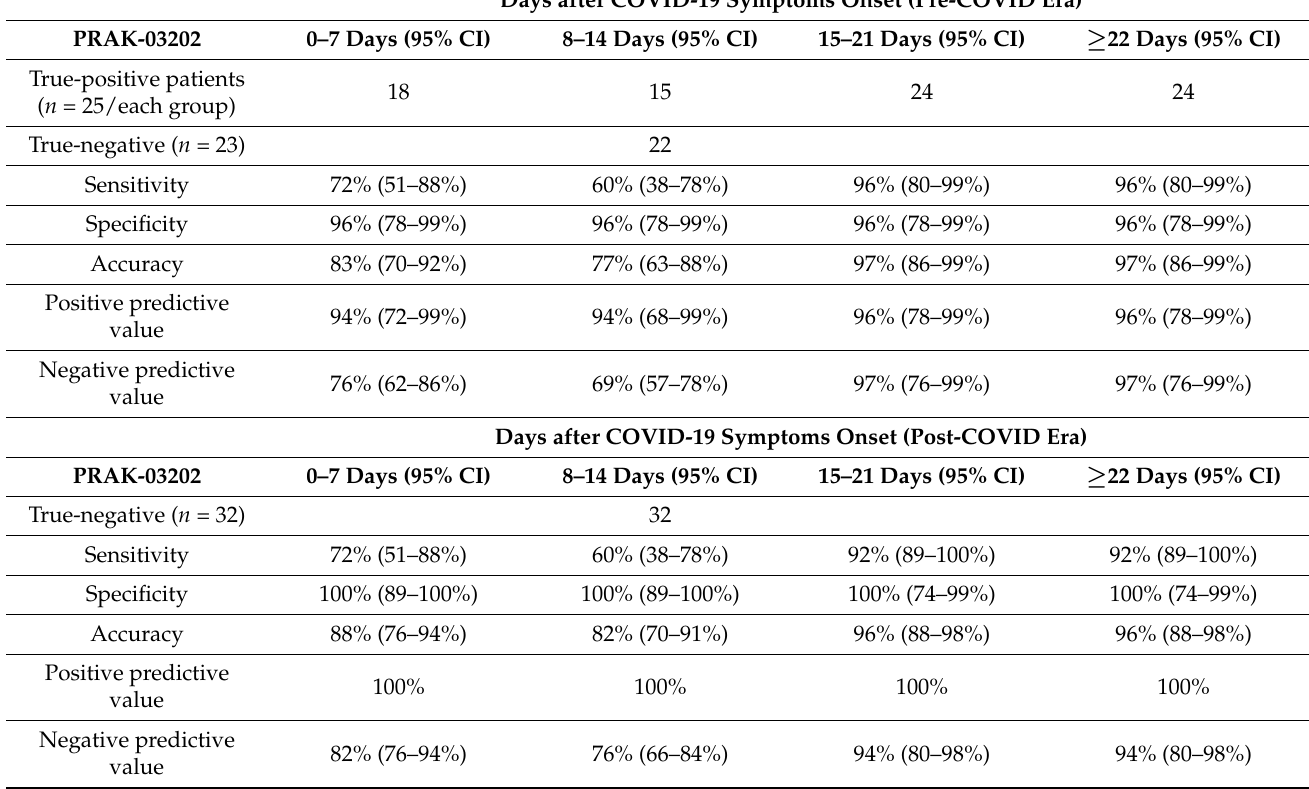
Table 3. Sensitivity, accuracy, positive, and negative predictive value of the VLP-ELISA assay to detect IgG antibodies in 23 rRT-PCR negative (pre-COVID era), 32 rRT-PCR negative (post-COVID-era), and 100 COVID-19-positive samples.